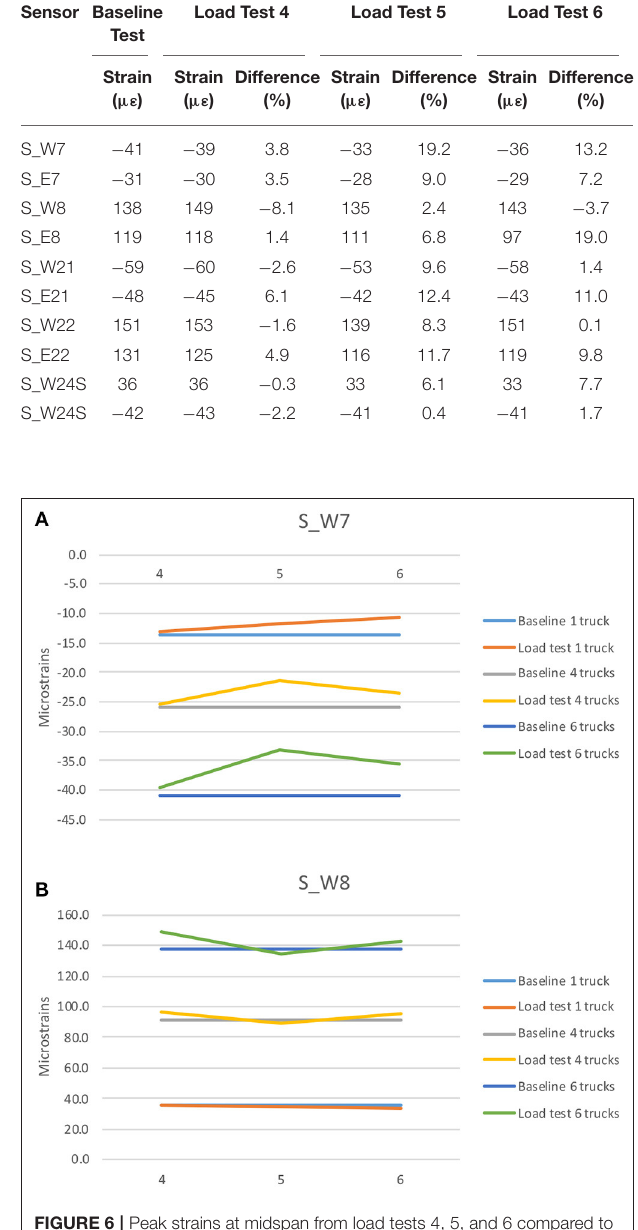
of the ten peak strain values during load test 6 was larger than the baseline value. In Figures 6 , 7 , one can graphically see how the peak strains have varied over time in comparison to the baseline value (the horizontal lines in the plots). This visual representation of the peak values shows that the ongoing response is quite similar to the baseline response, and with no discernable pattern of